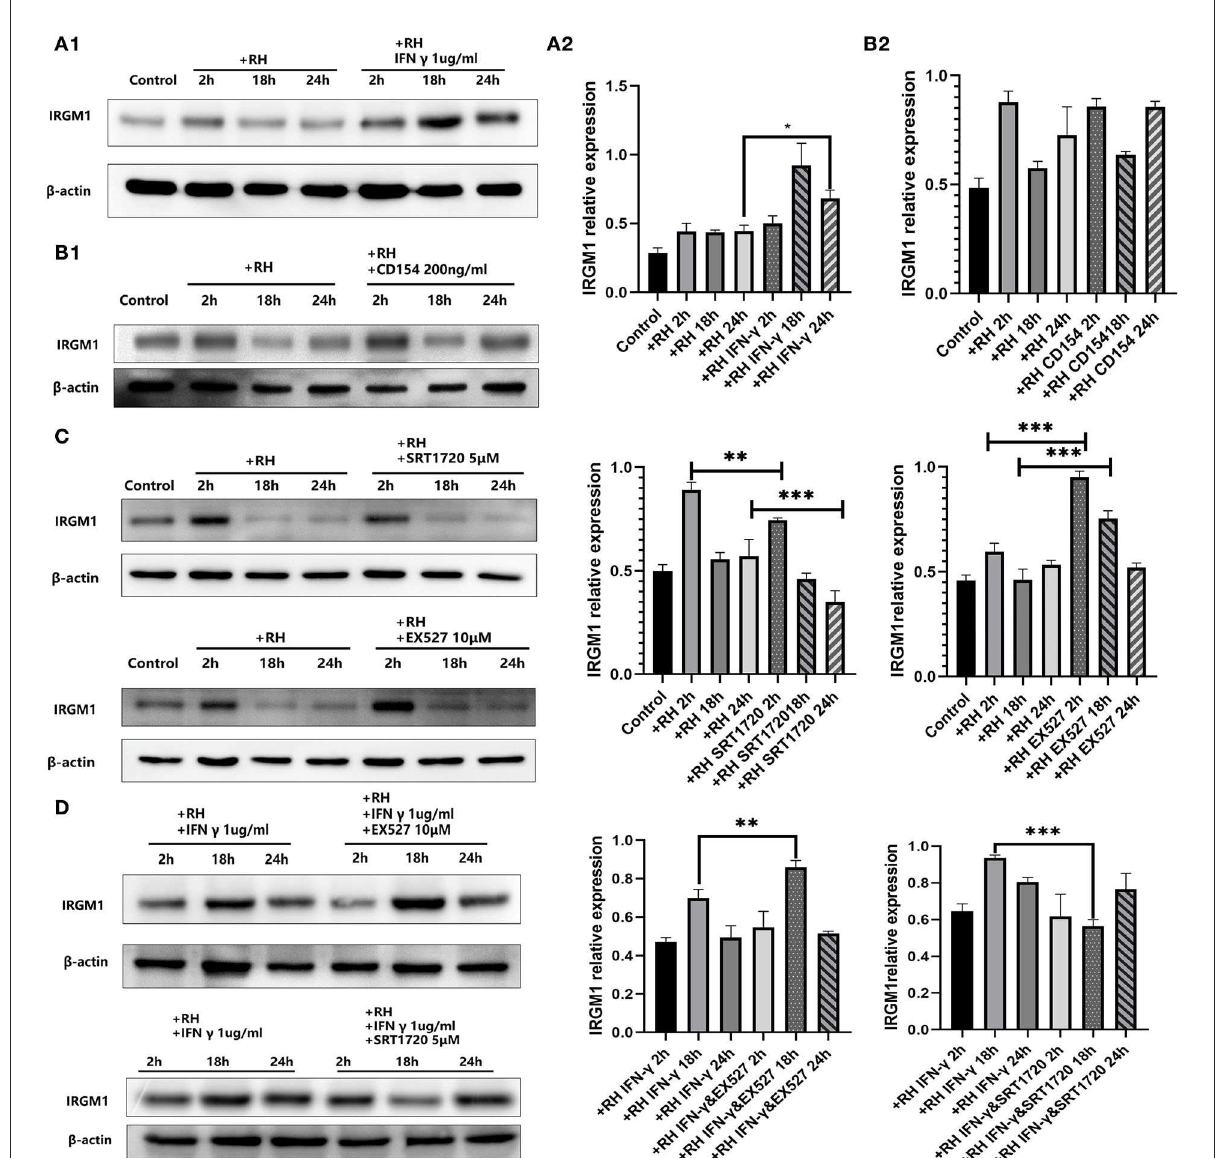
FIGURE5 Murine ortholog of immunity-related GTPase family M (IRGM1) regulation by Sirtuin 1 (SIRT1) with or without interferon gamma (IFN- γ ) or CD154 at different time points. RAW 264.7 macrophages were either infected with RH tachyzoites at a ratio of 5:1 (parasite/host cell) for 2h or left in the culture plate without infection, followed by incubation with IFN- γ (1 µ g/ml), CD154 (200ng/ml), SRT1720 (5 µ M), EX527 (10 µ M), IFN- γ (1 µ g/ml) and SRT1720 (5 µ M), or IFN- γ (1 µ g/ml) and EX527 (10 µ M) for 2, 18, or 24h before the collection of the cell lysates. We adjusted the protein concentration of each group of samples to be consistent and then carried out the experiment. Anti-IRGM1 antibody and anti-beta-Actin antibody were used at a 1:1,000 dilution. (A) The expression of IRGM1 in the Toxoplasma gondii infection group increased at 2h but decreased at 18 and 24h compared to that for the control group. Infected macrophages treated with IFN- γ displayed an upregulation of IRGM1 at 2, 18, and 24h compared to that of the infection-only group. (B) Infected macrophages treated with CD154 showed no significant changes of IRGM1 compared to that for the infection-only group. (C) Infected macrophages treated with RH tachyzoites showed an upregulation of IRGM at 2h and a downregulation at 18 or 24h compared to that of the control group. Meanwhile, IRGM1 production was found to be decreased under SRT1720 stimulation and increased with the existence of EX527 at 2h. However, both SRT1720 and EX527 failed to interfere with the IRGM1 level at 18 and 24h. (D) When combining SIRT1 interference and IFN- γ stimulation, infected macrophages treated with IFN- γ and SRT720 showed a downregulation of IRGM at 2, 18, and 24h compared to that of the IFN- γ group. Meanwhile, infected macrophages treated with IFN- γ and EX527 showed an upregulation of IRGM at 2, 18, and 24h compared to that of the IFN- γ group. These results were obtained from three independent experiments. RH, T. gondii RH strain. * P < 0.05, ** P < 0.01, and *** P <